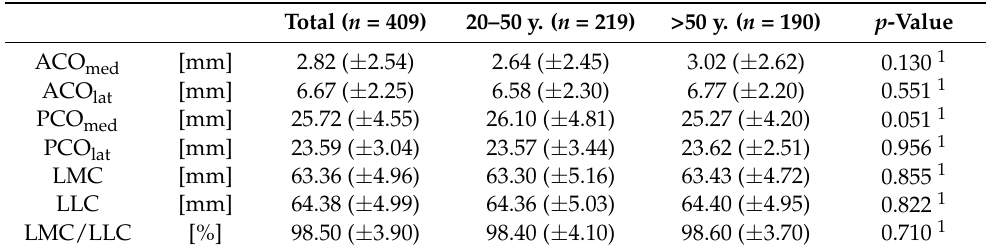
Table 4. Analysis of age-specific (age in years) differences for femoral condylar parameters in patients with radiologically healthy knee joints ( n =